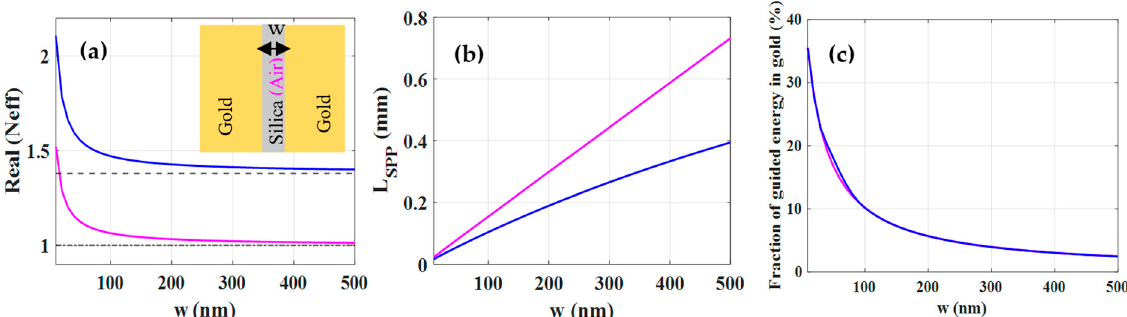
Figure 3. ( a ) The real parts of effective mode index ( N ef f ) of gold-silica-gold (blue curve) and gold- air-gold (magenta curve) MDM structures as a function of silica (air) thickness ( w ). The dashed line and dash-dotted line show the refractive index of silica and air, respectively. ( b ) The propagation length of MDM structures versus w . ( c ) The fraction of guided electromagnetic energy in gold as a function of w .